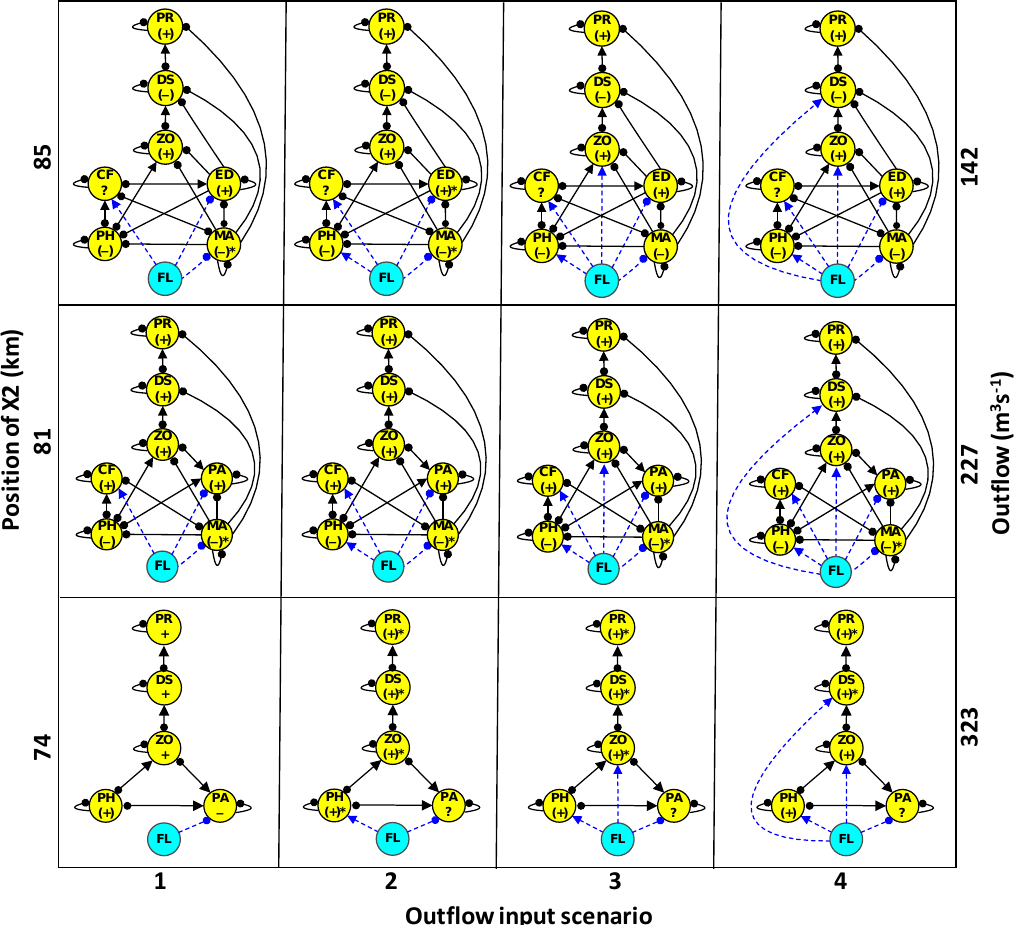
Figure 4. Signed digraphs of the modeled delta smelt subsystems at three positions of the 2 psu isohaline (X2) in the upper San Francisco Estuary. Dashed lines indicate the four alternative outflow (FL) input scenarios for community variables. Dashed lines in scenario 1 represent outflow perturbations to Corbicula fluminea (CF), Egeria densa (ED), Microcystis aeruginosa (MA), and Potamocorbula amurensis (PA). Dashed lines in outflow scenarios 2, 3, and 4 cumulatively add outflow perturbations to phytoplankton (PH, scenario 2), zooplankton (ZO, scenario 3), and delta smelt (DS, scenario 4). PR denotes predators of delta smelt. Community variables show the predicted direction of change in abundance ( + , − ) in response to sustained outflow input. Direction of change without parentheses is unconditional. Direction of change in parentheses denote high-certainty (asterisk) and low-conditional certainly (no asterisk), and ? denotes complete ambiguity.